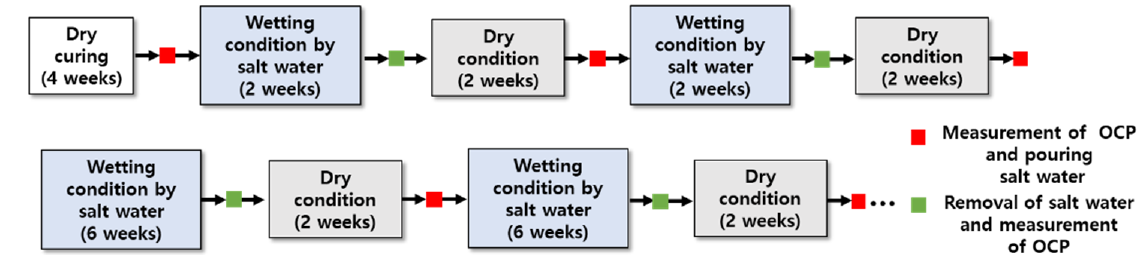
Figure 5. Accelerated corrosive conditions for the corrosion monitoring test.